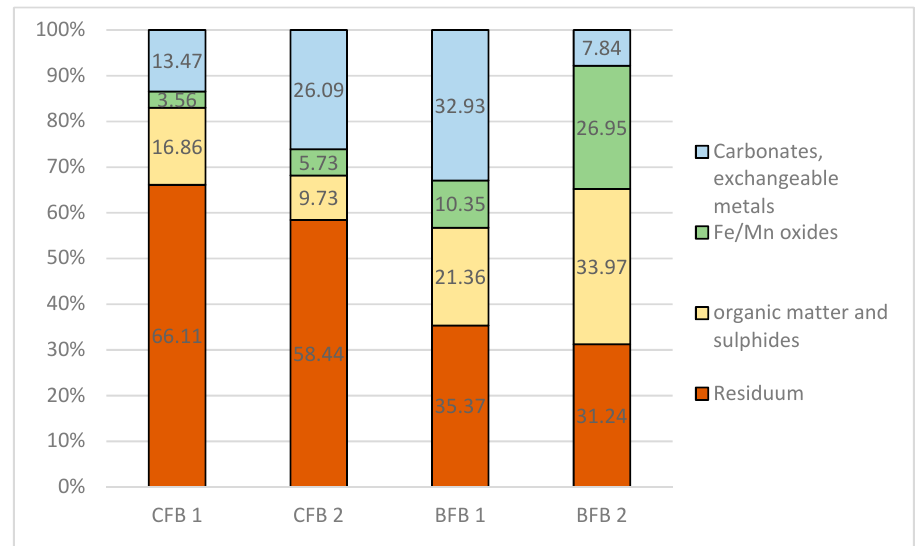
Figure 2. Speciation of Pb in fly ash.